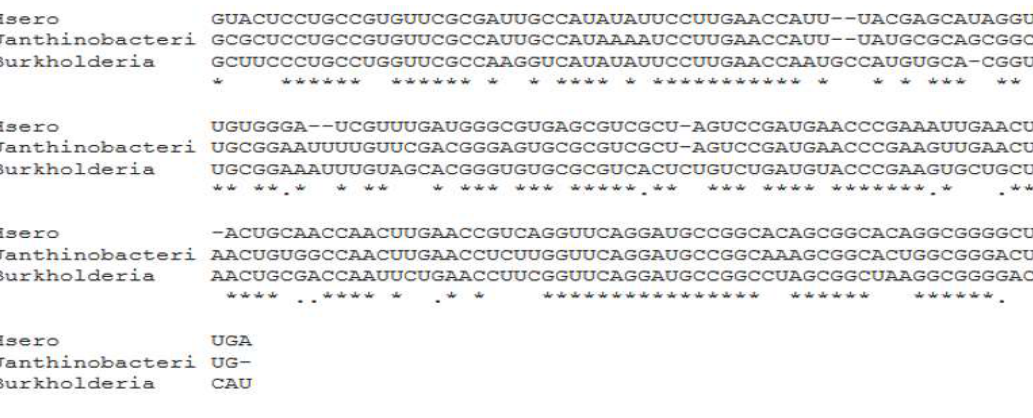
Figure 8. Multiple alignment of 6S ncRNA gene sequences by the CLUSTALW tool. Hsero = Herbaspirillum seropedicae SmR1; Janthinobacteri = Janthinobacterium sp .; and Burkholderia = Burkholderia CCGE1003.